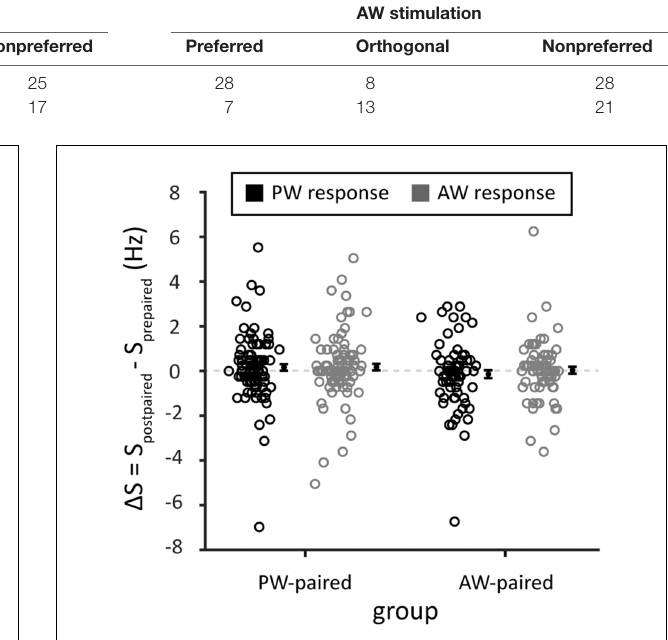
FIGURE 8 | Spontaneous spiking rates before and after the paired stimulation. The mean of the changes in spontaneous spiking rates, obtained from the blank trials among whisker stimulations, before and after paired stimulation ( (cid:52) S = S postpaired sti . − S prepaired sti . ) was close to zero in any stimulated whiskers or by any whisker that received paired stimulation ( p > 0.05 in all conditions). S postpairedsti. and S prepairedsti. indicated spontaneous spiking rates before and after the paired stimulation, respectively. Black and gray circles indicate PW and AW stimulations,